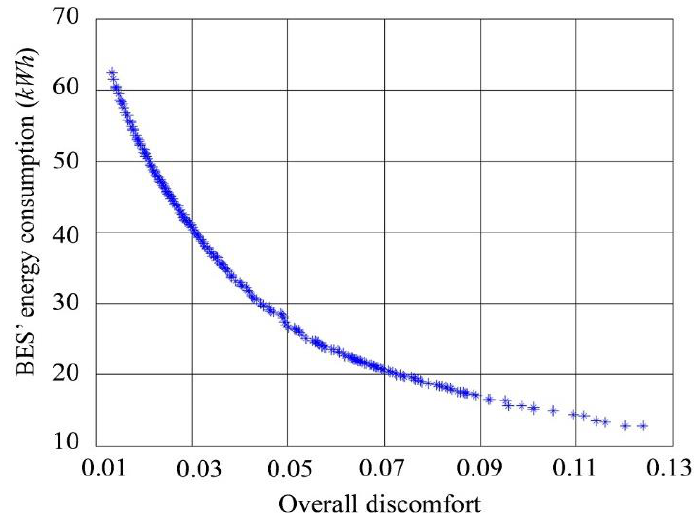
Figure 4. Pareto-optimal front of energy consumption versus overall dis-comfort